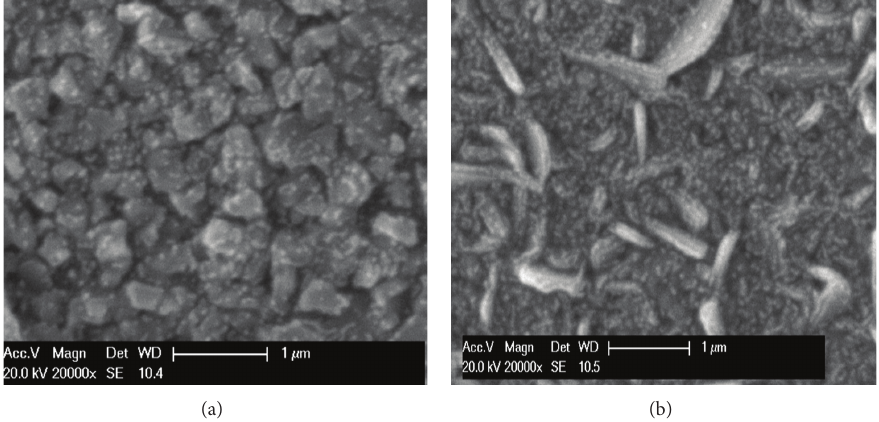
Figure 1: 1 SEM pictures of the CZT thin films: (a) sample CTS-3; (b) sample CTS-4.